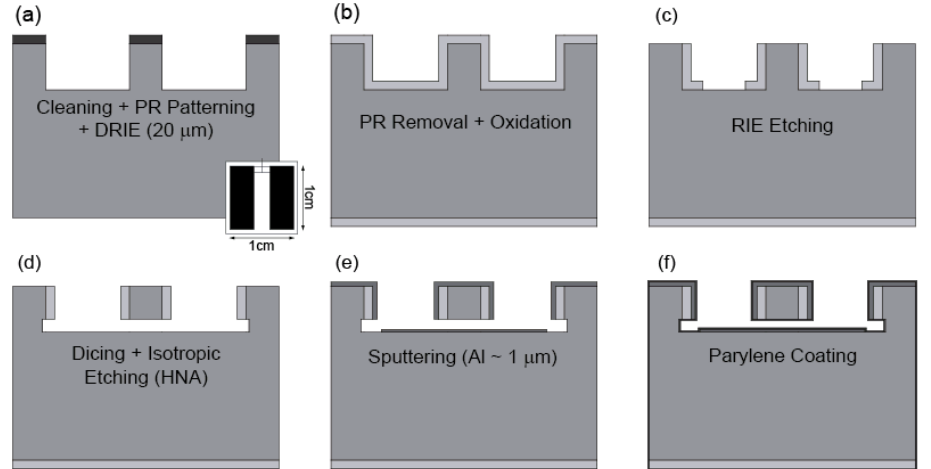
Fig. 2 MEMS fabrication process using Si wafer. (a) Silicon wafer is coated of with negative PR and patterned using Cr. Then the wafer is etched using DRIE to fabricate the silicon beam. (b) Wet oxidation process is followed for oxide layer formation. (c) RIE is performed to etch the planar oxide layer for isotropic etching, the vertical layer is left for protection. (d) Wafer is diced into 1 cm × 1 cm devices for convenience. Then each device is etched with HNA solution. (e) Al is sputtered to form electrodes. (f) Parylene deposition to create an insulation layer.